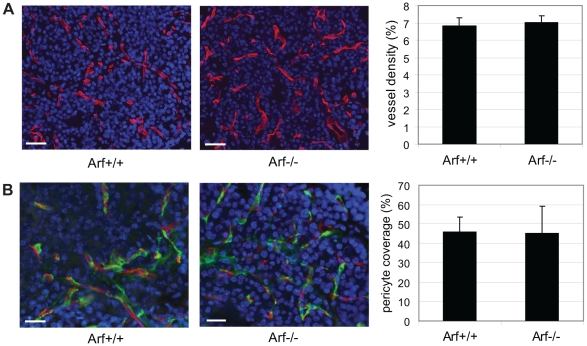
Effects of Arf knockout on the angiogenic vasculature.(A) Visualization of the vasculature in angiogenic lesions from 8-week old RIP-Tag2 mice of the indicated genotypes by immunostaining for Meca32 (red). Representative Meca32/DAPI (blue) merged images are shown. Vessel density was calculated by measuring the area occupied by Meca32+ vessels; values represent the mean ±SEM calculated from analyzing 16–20 angiogenic lesions from 4 individual mice of each genotype. (B) Double immunostaining for Meca32 (endothelial cells, red) and NG2 (pericytes, green) was performed to analyze the degree of pericyte coverage within the angiogenic vasculature from 8-week RIP-Tag2 mice of the indicated genotypes. Bars, 20 µm.